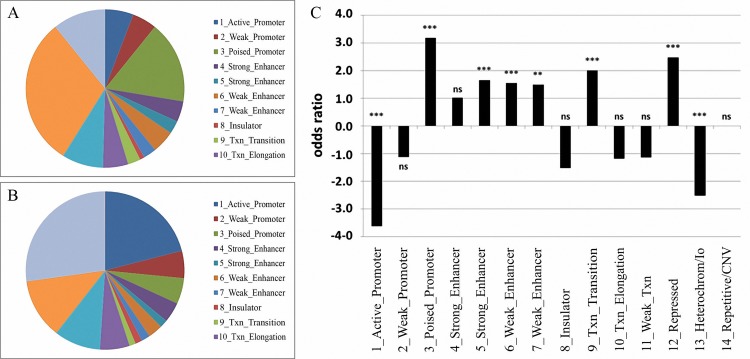
Enrichment of differentially methylated loci located in distinct chromosomal states.To determine the individual chromosomal state, data provided by the Ensembl database on the chromosomal state in NHEK cells were used. Pie charts of the chromatin states of differentially methylated loci (FDR<1.0x10-9, ANOVA, n = 2192 loci) (A) and all loci present on the HumanMethylation450 BeadChip included into this study (B) are presented. (C) Bar chart showing odds ratios of selected chromosomal states affected by differential DNA methylation in OSCC, OLP, and controls. ***: p<0.001; **: p<0.01; *: p<0.05; ns: not significant.